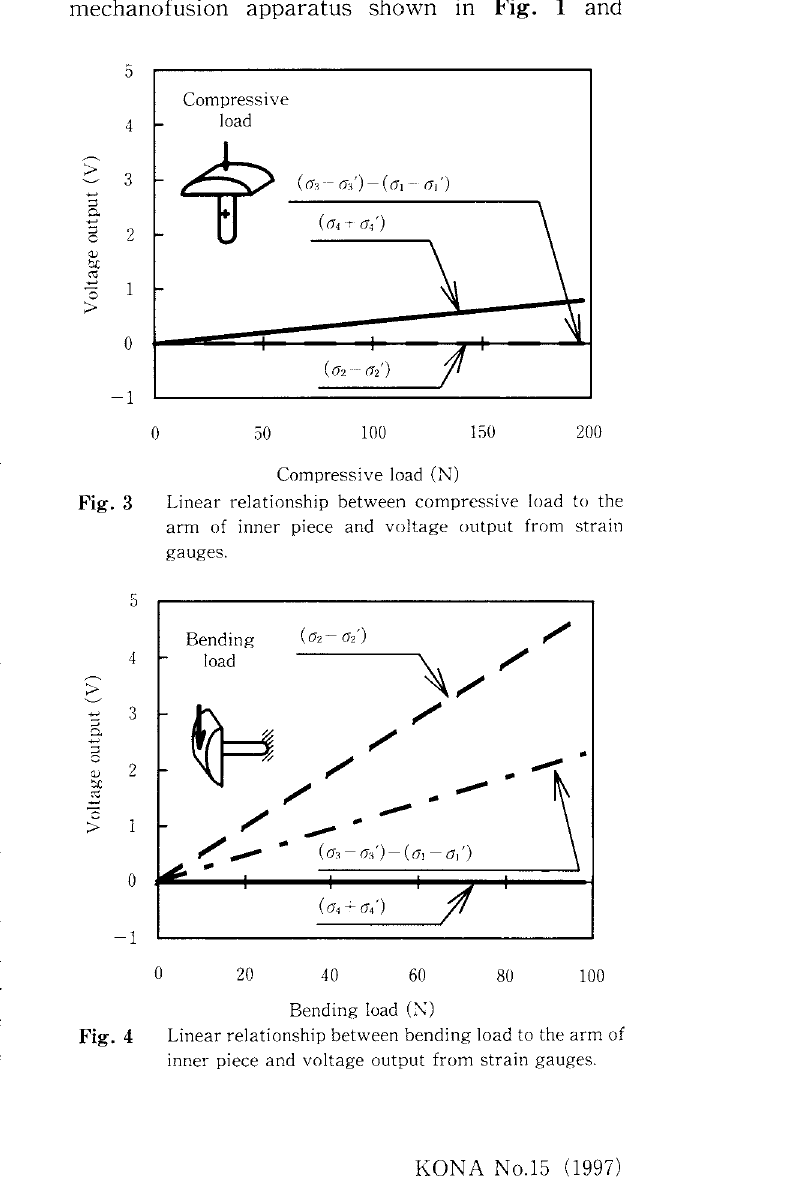
Bending load (::-\) Linear relationship between bending load to the arm of inner piece and voltage output from strain